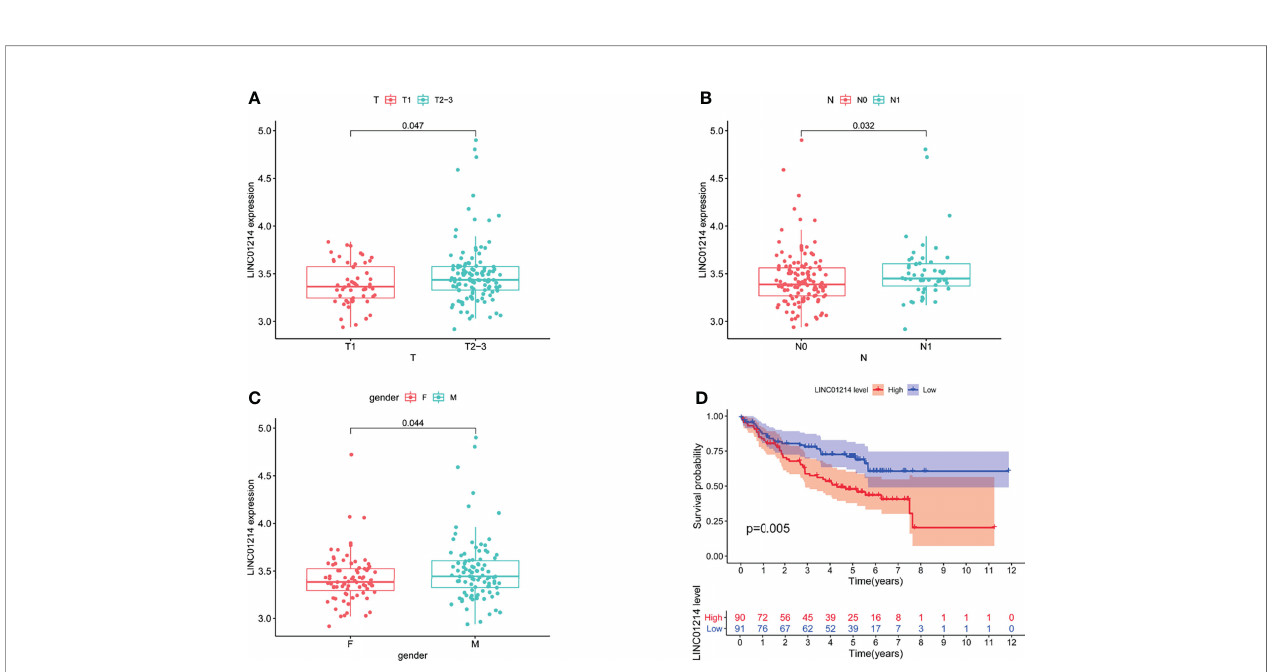
FIGURE 8 | Nomogram and calibration charts of LUAD patients based on the GILncSig. (A) Nomogram for predicting LUAD prognosis. (B) Calibration plots for the 1- year nomogram. (C) Calibration plots for the 3- year nomogram. (D) Calibration plots for the 5- year nomogram.